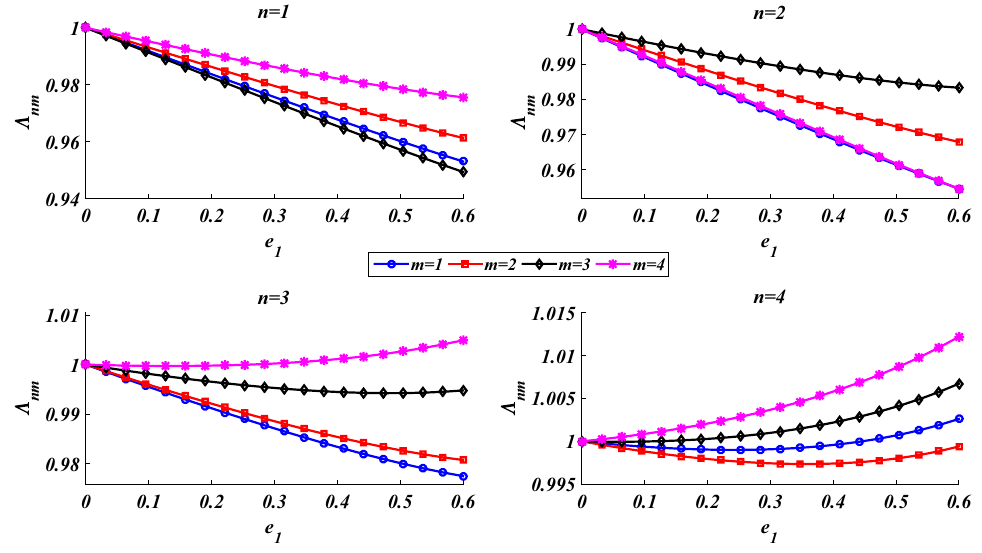
Figure 5. Dependency of the natural frequencies on the porosity parameter.